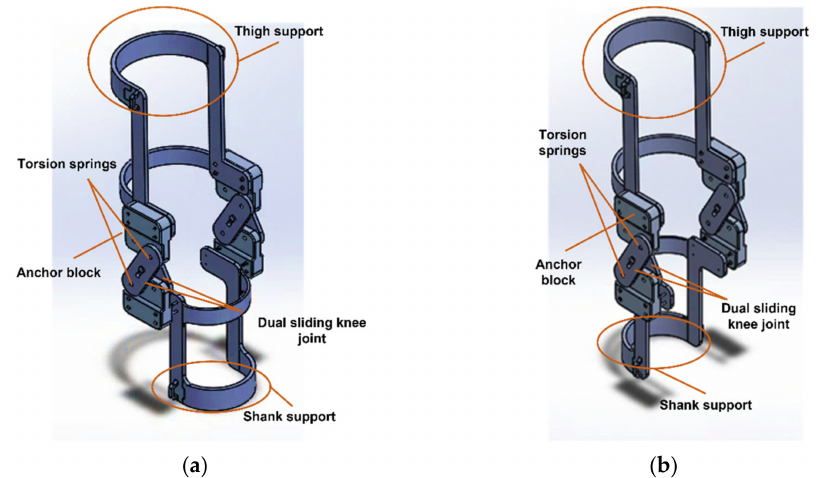
Figure 6. Two iterations of the passive exoskeleton where the thigh support should sit behind the thigh, and ( a ) shank support is worn in front of the leg, ( b ) shank support is worn behind the